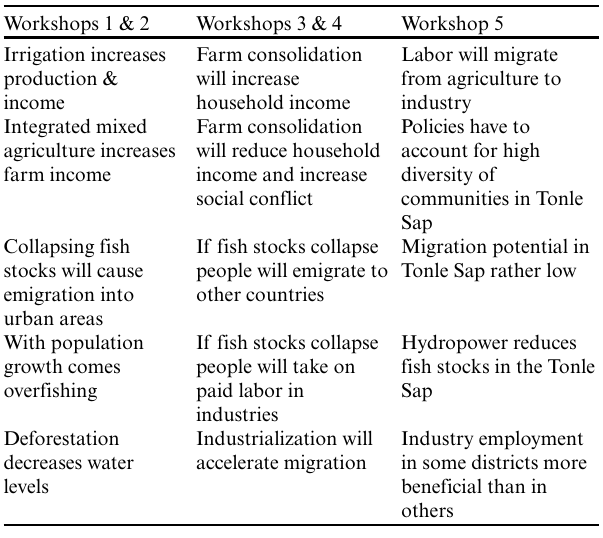
Table 3 . Beliefs recorded during the workshop process around the Tonle Sap,